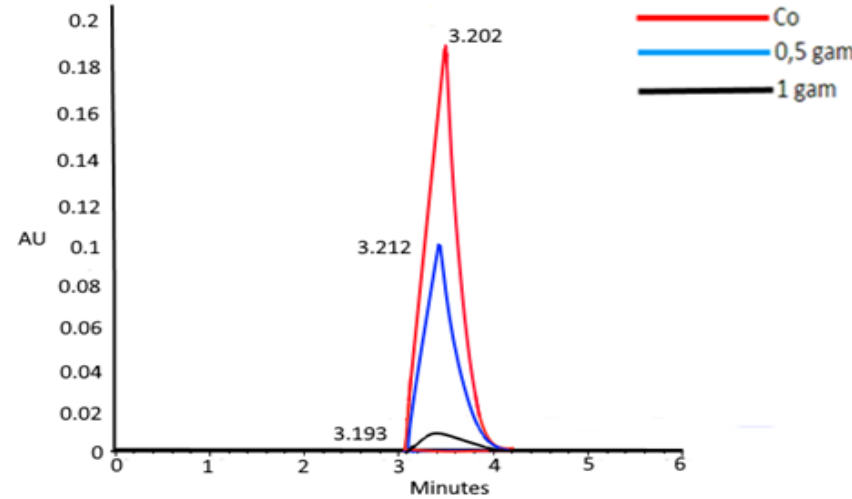
Figure 11. Chromatographic lines of a phenol solution sample depend on the amount of Fe-Cu material. Red curve: chromatogram of an untreated phenol sample (100.98 mg/L). Blue curve: chromatogram of a phenol sample treated with the following conditions: initial phenol concentration of 100.98 mg/L, Fe-Cu material weight of 5 g/L, shaking time of 12 h, shaking speed of 200 rpm, at pH = 3. Black curve: chromatogram of a phenol sample treated with the following conditions: initial phenol concentration of 100.98 mg/L, Fe-Cu material weight of 10 g/L, shaking time of 12 h, shaking speed of 200 rpm, at pH = 3.